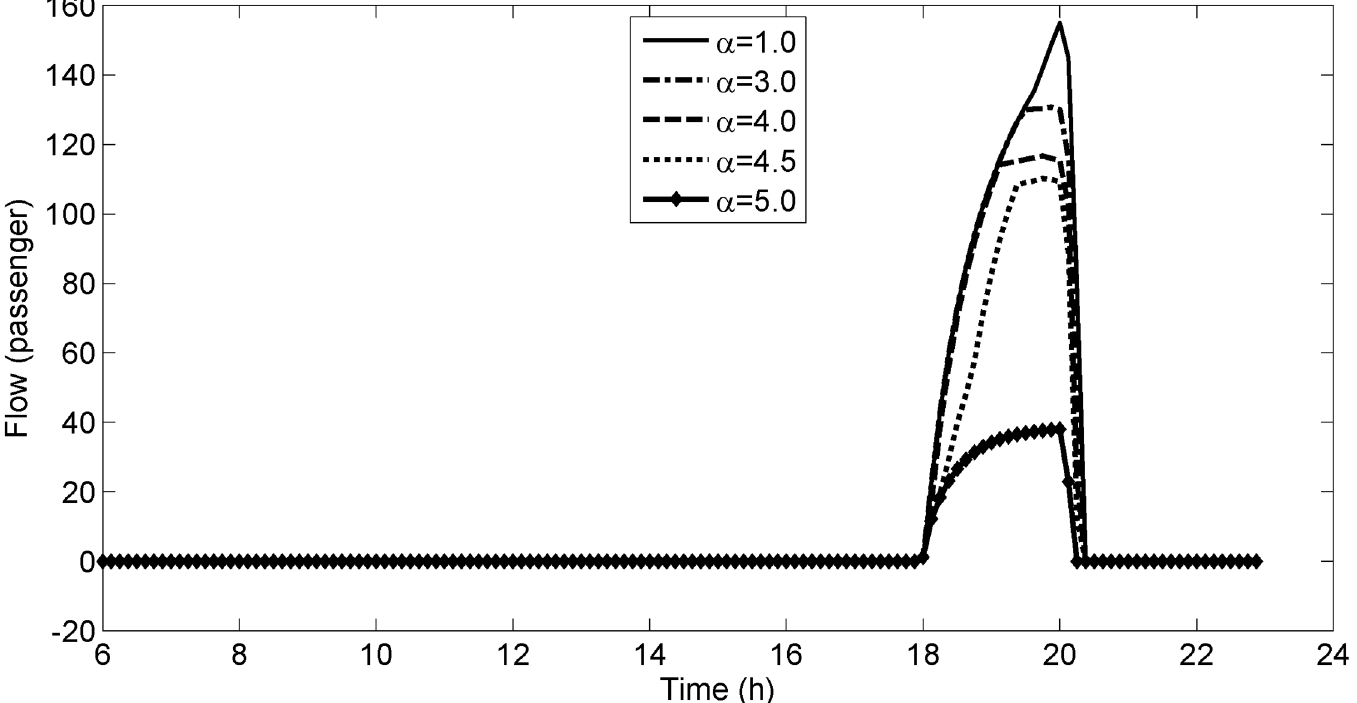
for different values of parameter α . 1 U